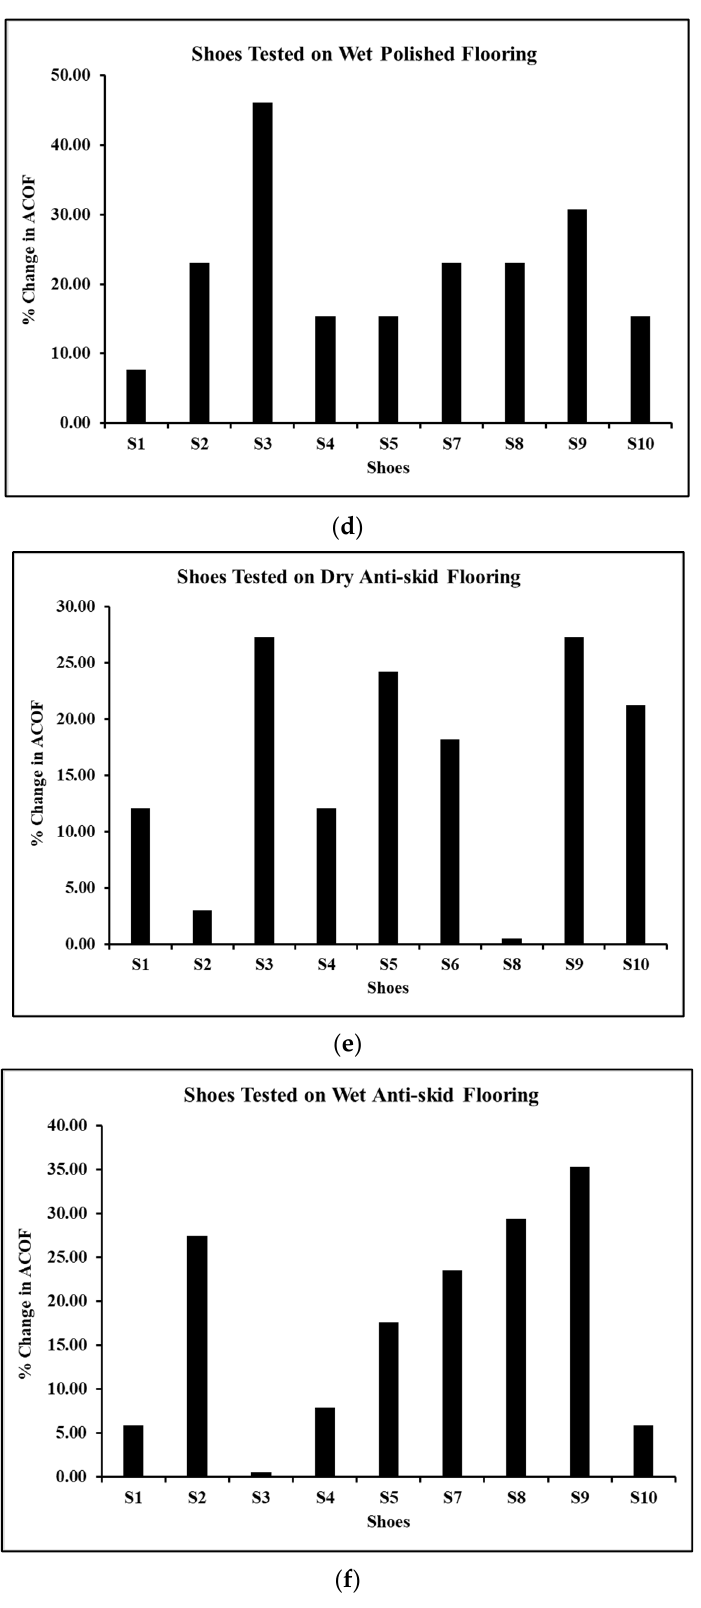
Figure 8. The ACOF of shoes in ( a ) dry condition and ( b ) wet condition. Percentage difference in the ACOF of shoes tested against ( c ) Shoe 1 on dry polished flooring, ( d ) Shoe 6 on wet polished flooring, ( e ) Shoe 7 on dry anti-skid flooring, and ( f ) Shoe 7 on wet anti-skid flooring.